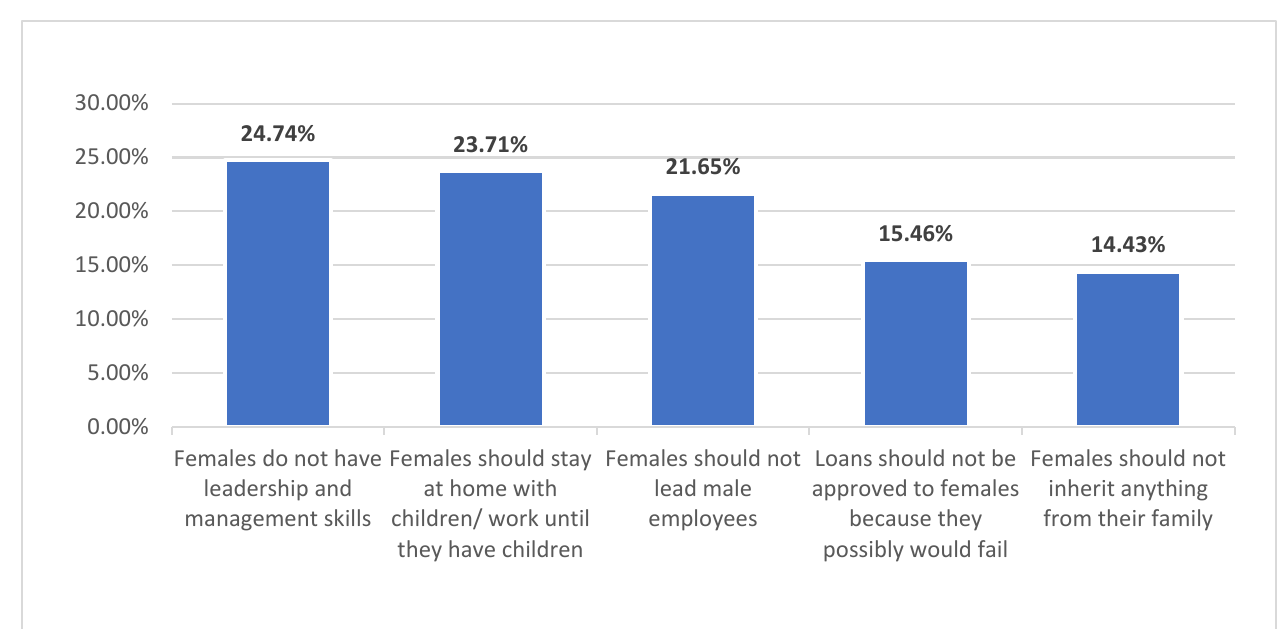
Figure 3. Most discriminatory statements (N = 36). Source: (authors(cid:31) own elaboration).